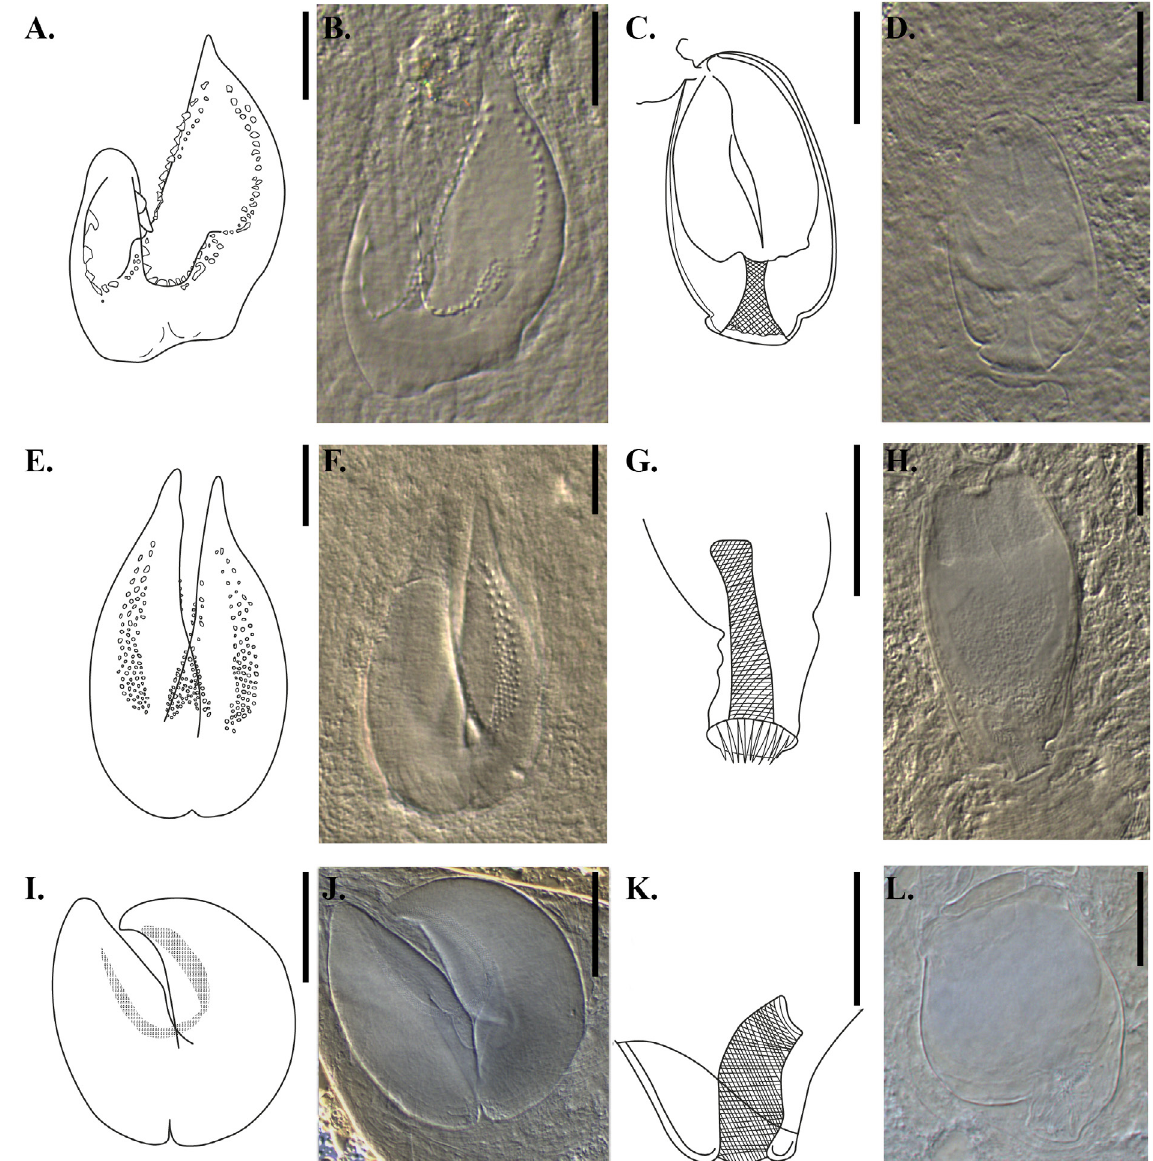
Fig. 3. A–D . Carcharodorhynchus tenuis Brunet, 1979 (HU X.1.46). A–B . Proboscis. C–D . Copulatory bulb. E–H . C. flavidus Brunet, 1967. E–F . Proboscis (HU X.1.49). G–H . Copulatory bulb (HU X.1.48– 49). I–L . C. multidentatus Brunet, 1979 (HU X.1.50). I–J . Proboscis. K–L . Copulatory organ. Scale bars: 20